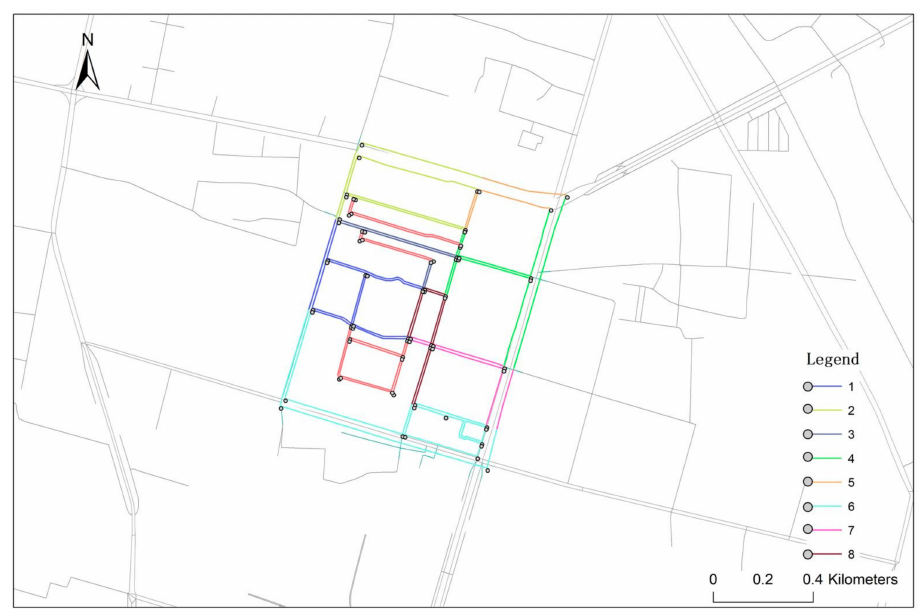
Figure 5. Final route after optimization in real